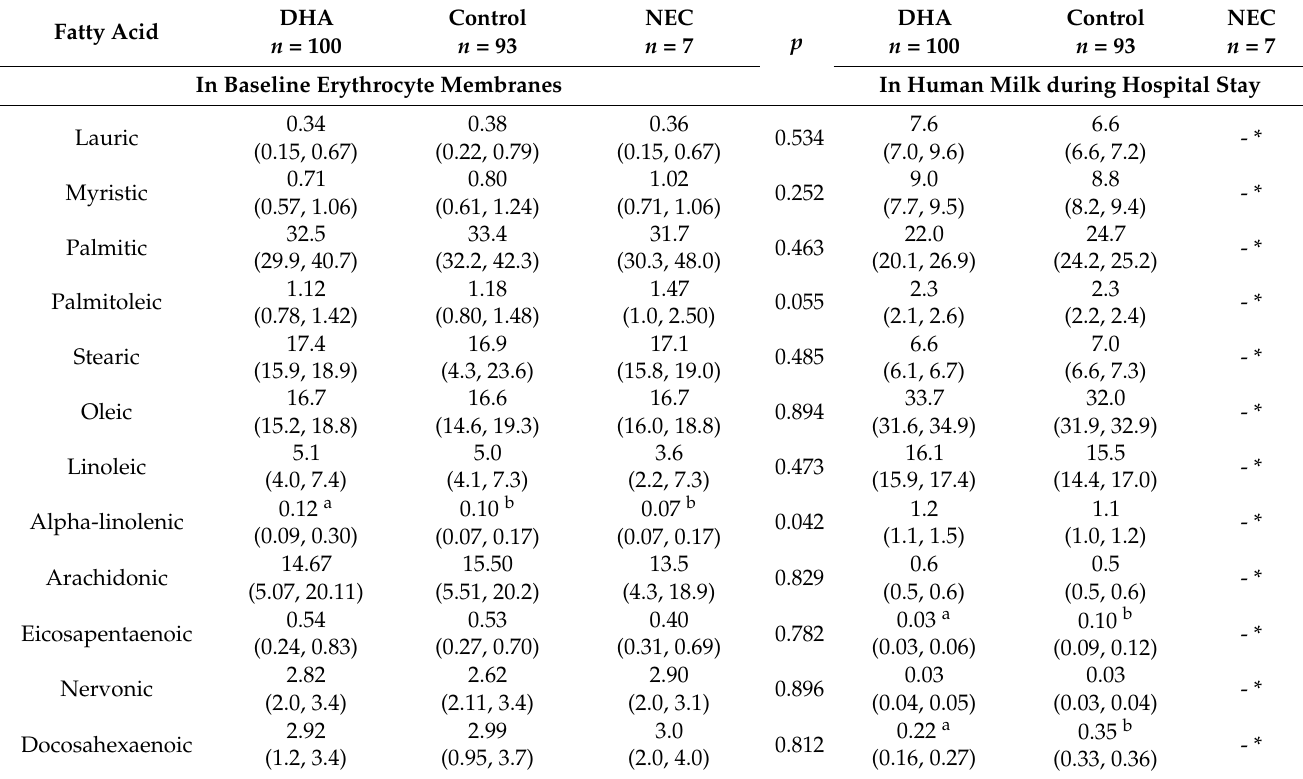
Table 5. Fatty acid profile of erythrocyte membranes from preterm infants and of human milk (%weight of total fatty